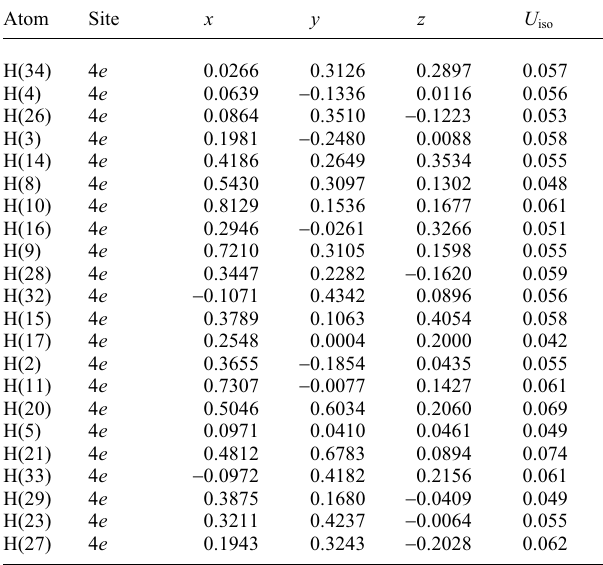
Table 2. Atomic coordinates and displacement parameters (in Å 2 )